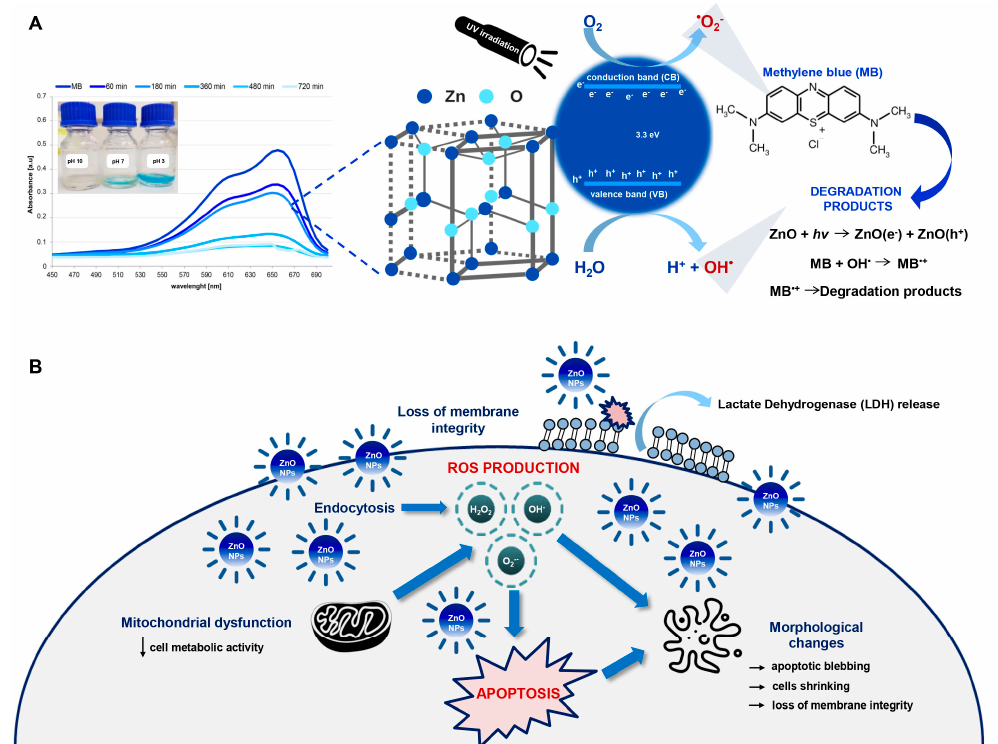
Figure 7. The proposed mechanism of ( A ) photocatalytic degradation of methylene blue and ( B ) cytotoxicity of functional- ized ZnO